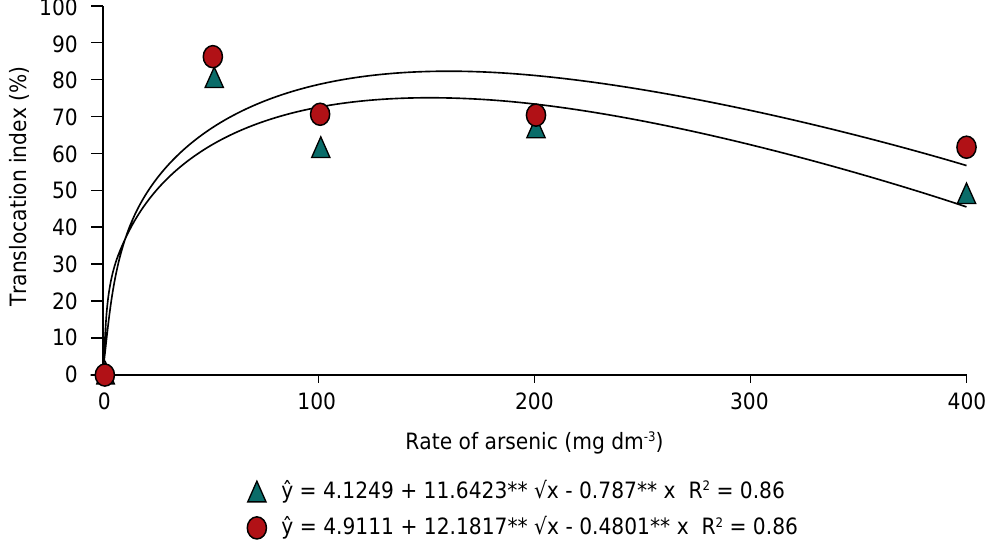
Figure 2. Translocation index of arsenic in plants of E. urophylla and E. citriodora according to the arsenic rate applied to the soil. **, *: at 1 and 5 % significant, respectively, by the F